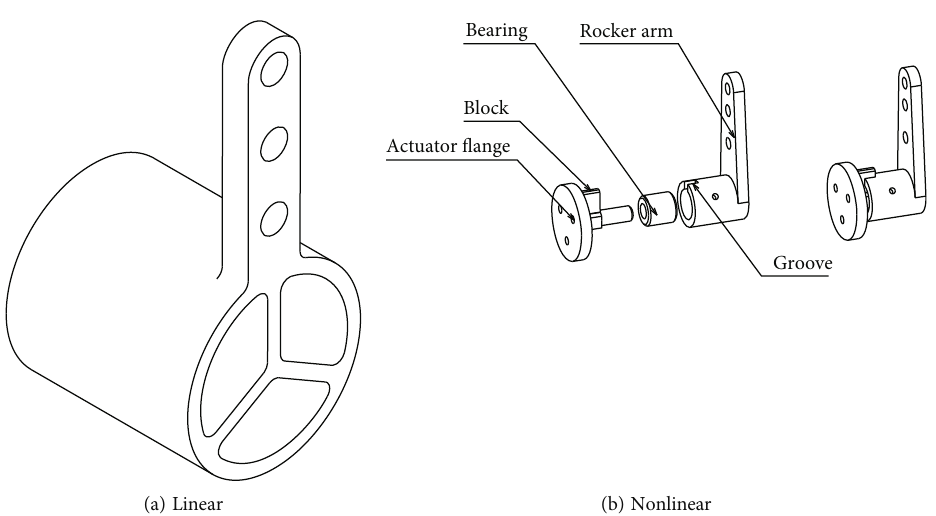
Figure 5: The design of rotational arms of the actuator.